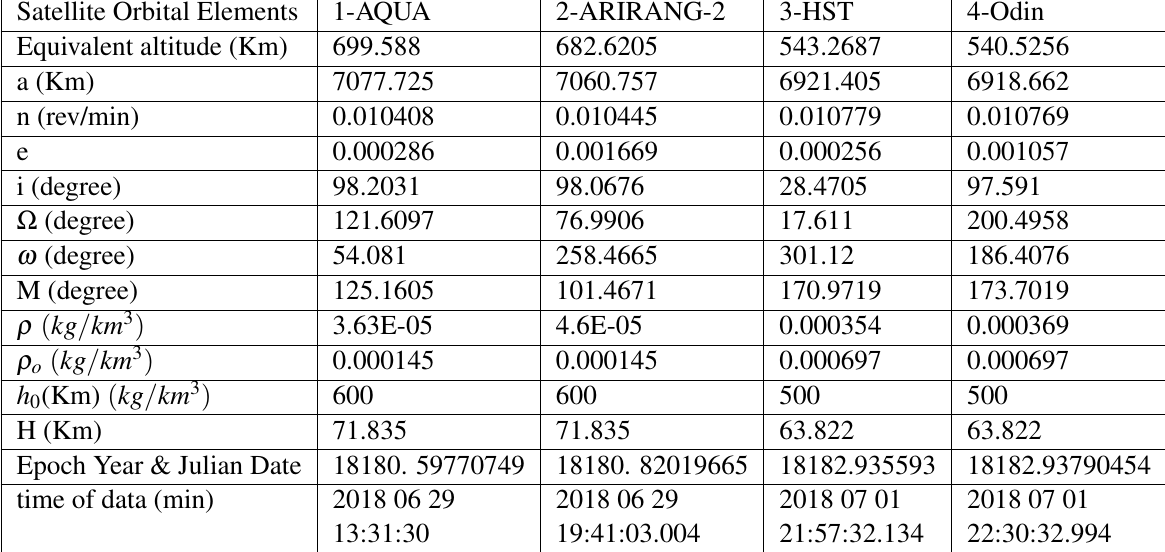
Table 1 Norad Two - Line Element Sets For The Satellites AQUA, ARIRANG-2, HST and ODIN Satellite Orbital Elements